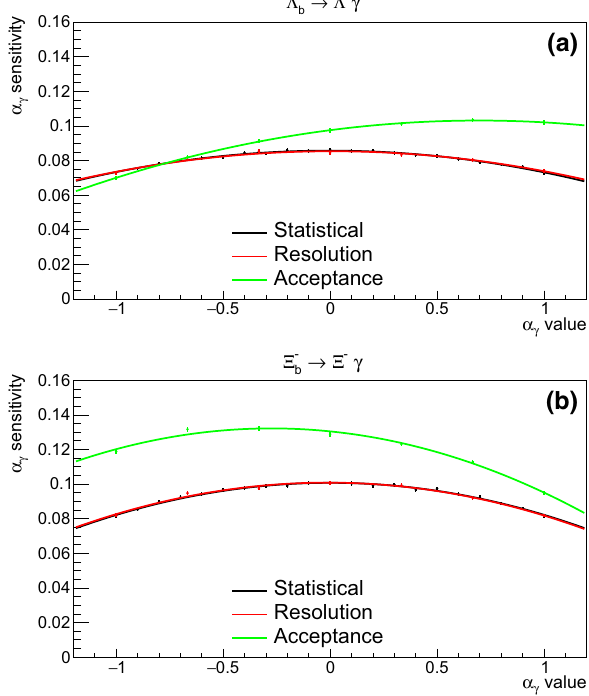
Fig. 6 a Sensitivity to the photon polarization as function of its value for Λ 0 ( a )and Ξ − ( b )casesincludingangularresolutionandacceptance b b effects. Dots with errors corresponds to the fit results. A second order polynomial is superimposed for better